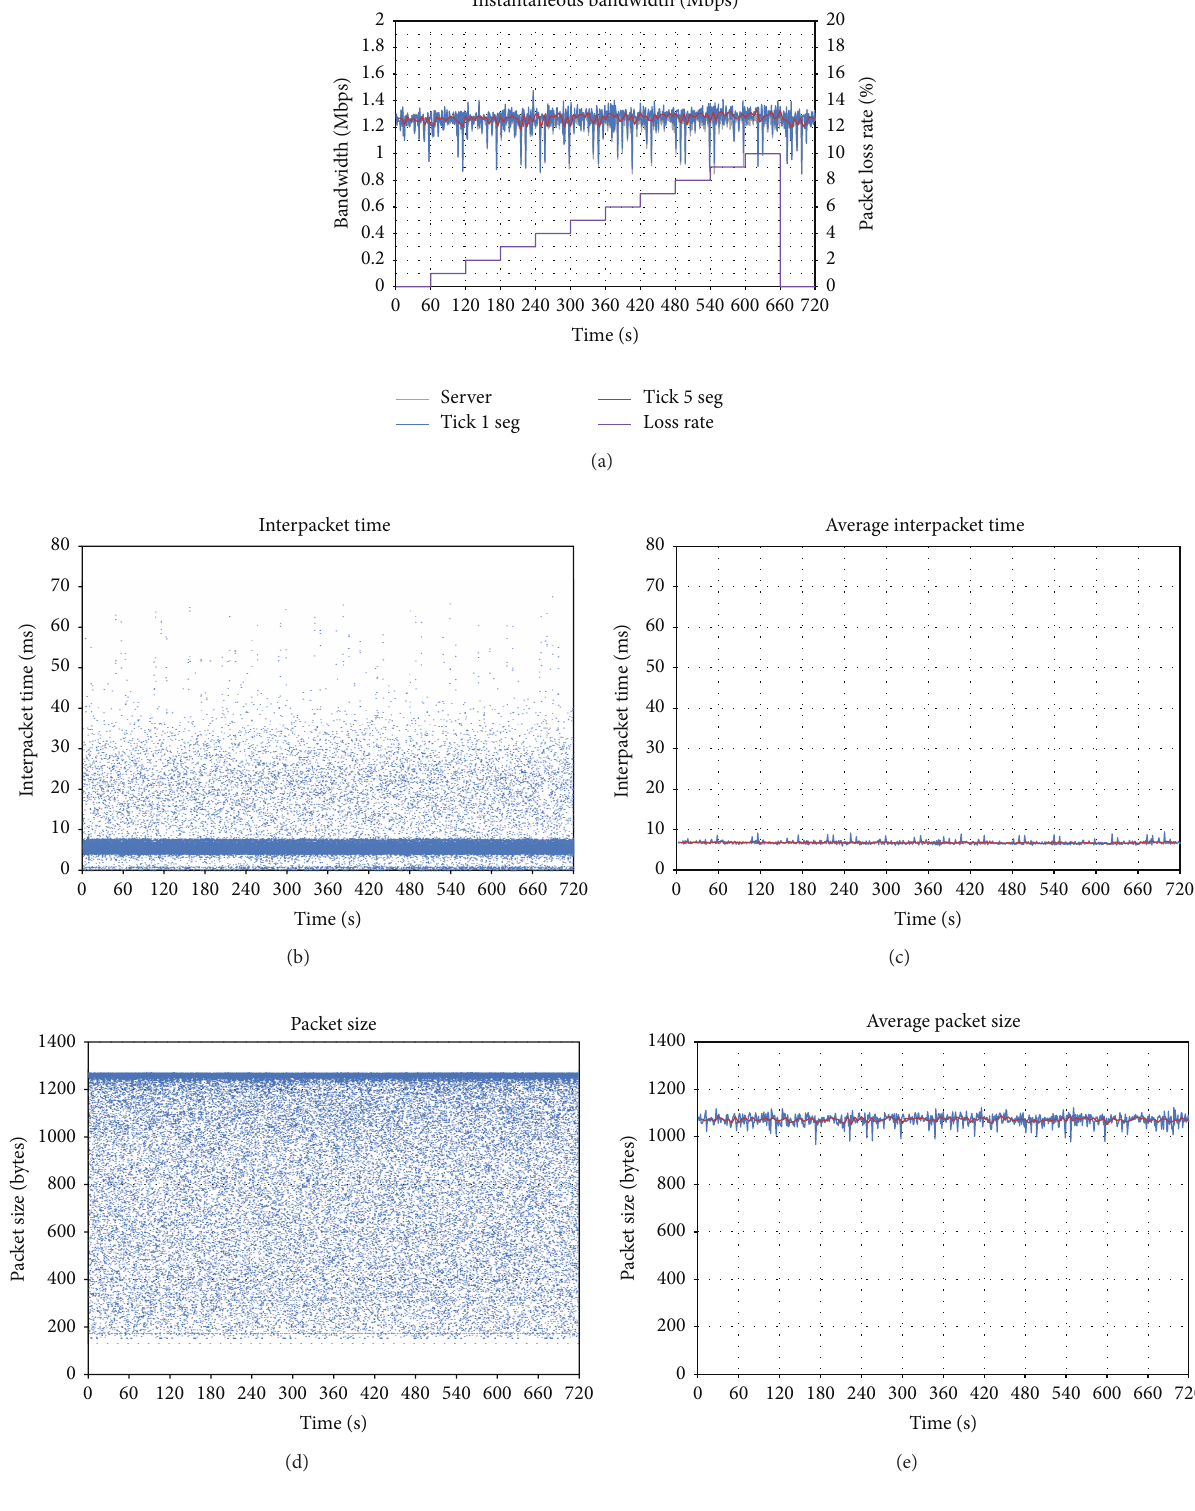
Figure 4: Effect of downlink packet loss on Vidyo : (a) evolution of sent throughput; (b) interpacket time; (c) average interpacket time; (d) packet size; (e) average packet size